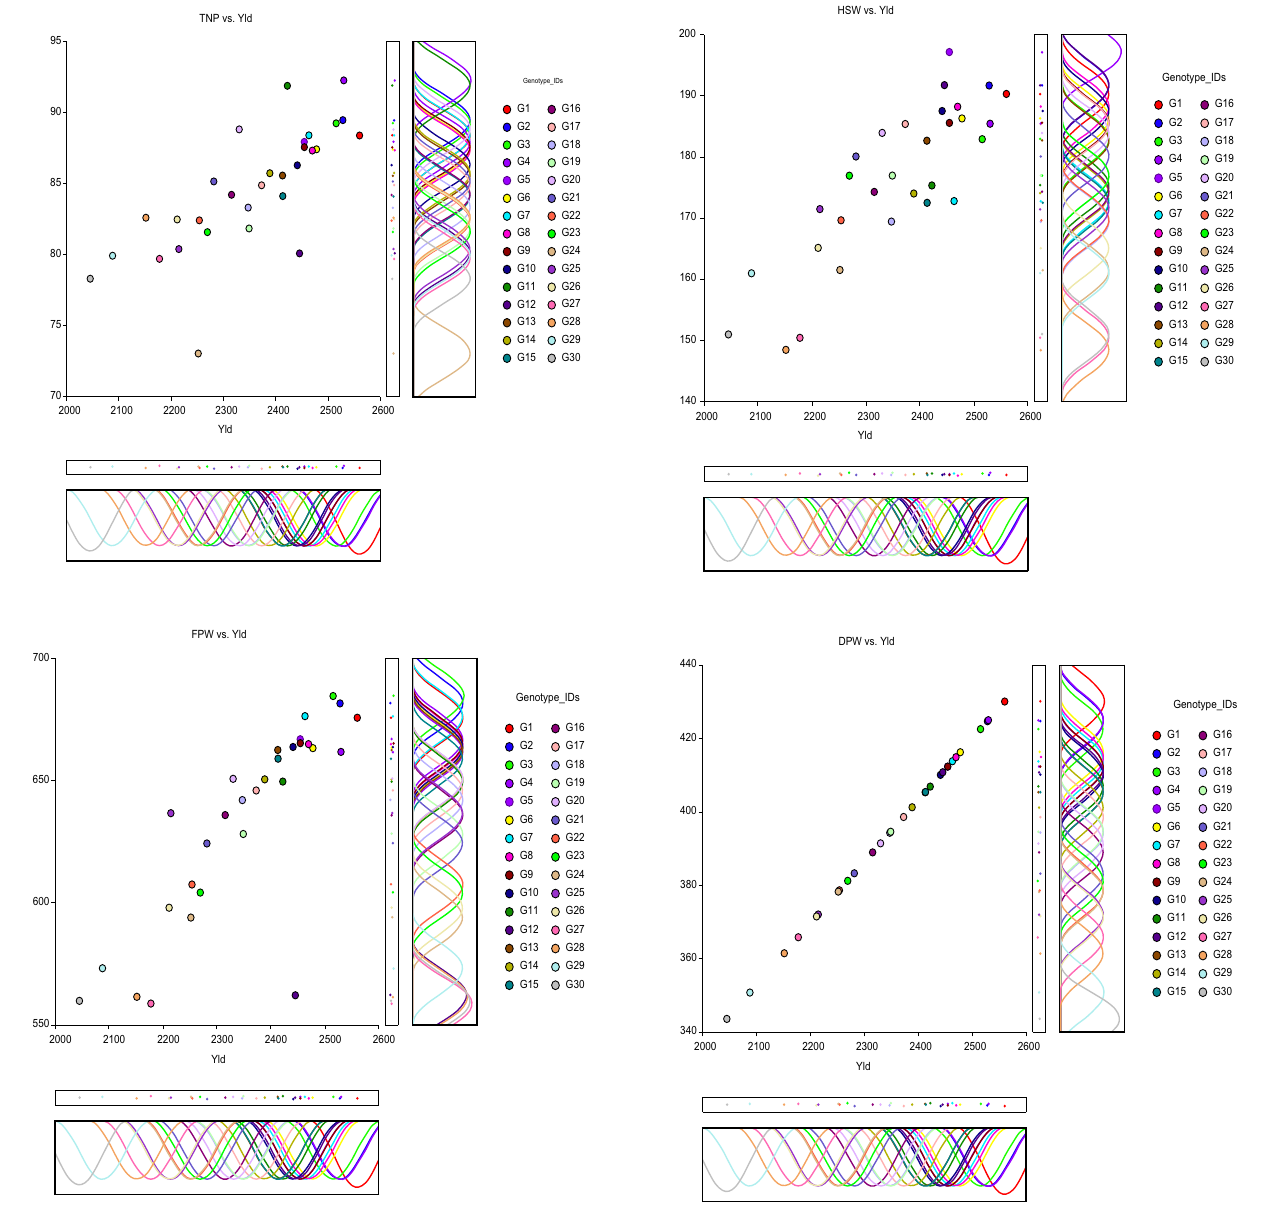
Figure 2. Scatter matrix with density and dot plot illustrates the graphical relationship of yield and its components in Bambara groundnut accessions revealed by NCSS 2021. ( A ) The total number of pods (TNP) vs Yield, ( B ) Fresh pods weight (g) (FWP) vs Yield, ( C ) Hundred seed weight (g) (HSW) vs Yield, ( D ) Dry pods weight (g) (DPW) vs